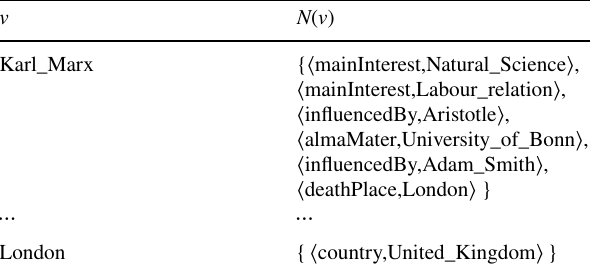
Table 1 The adjacency list of RDF graph G 1